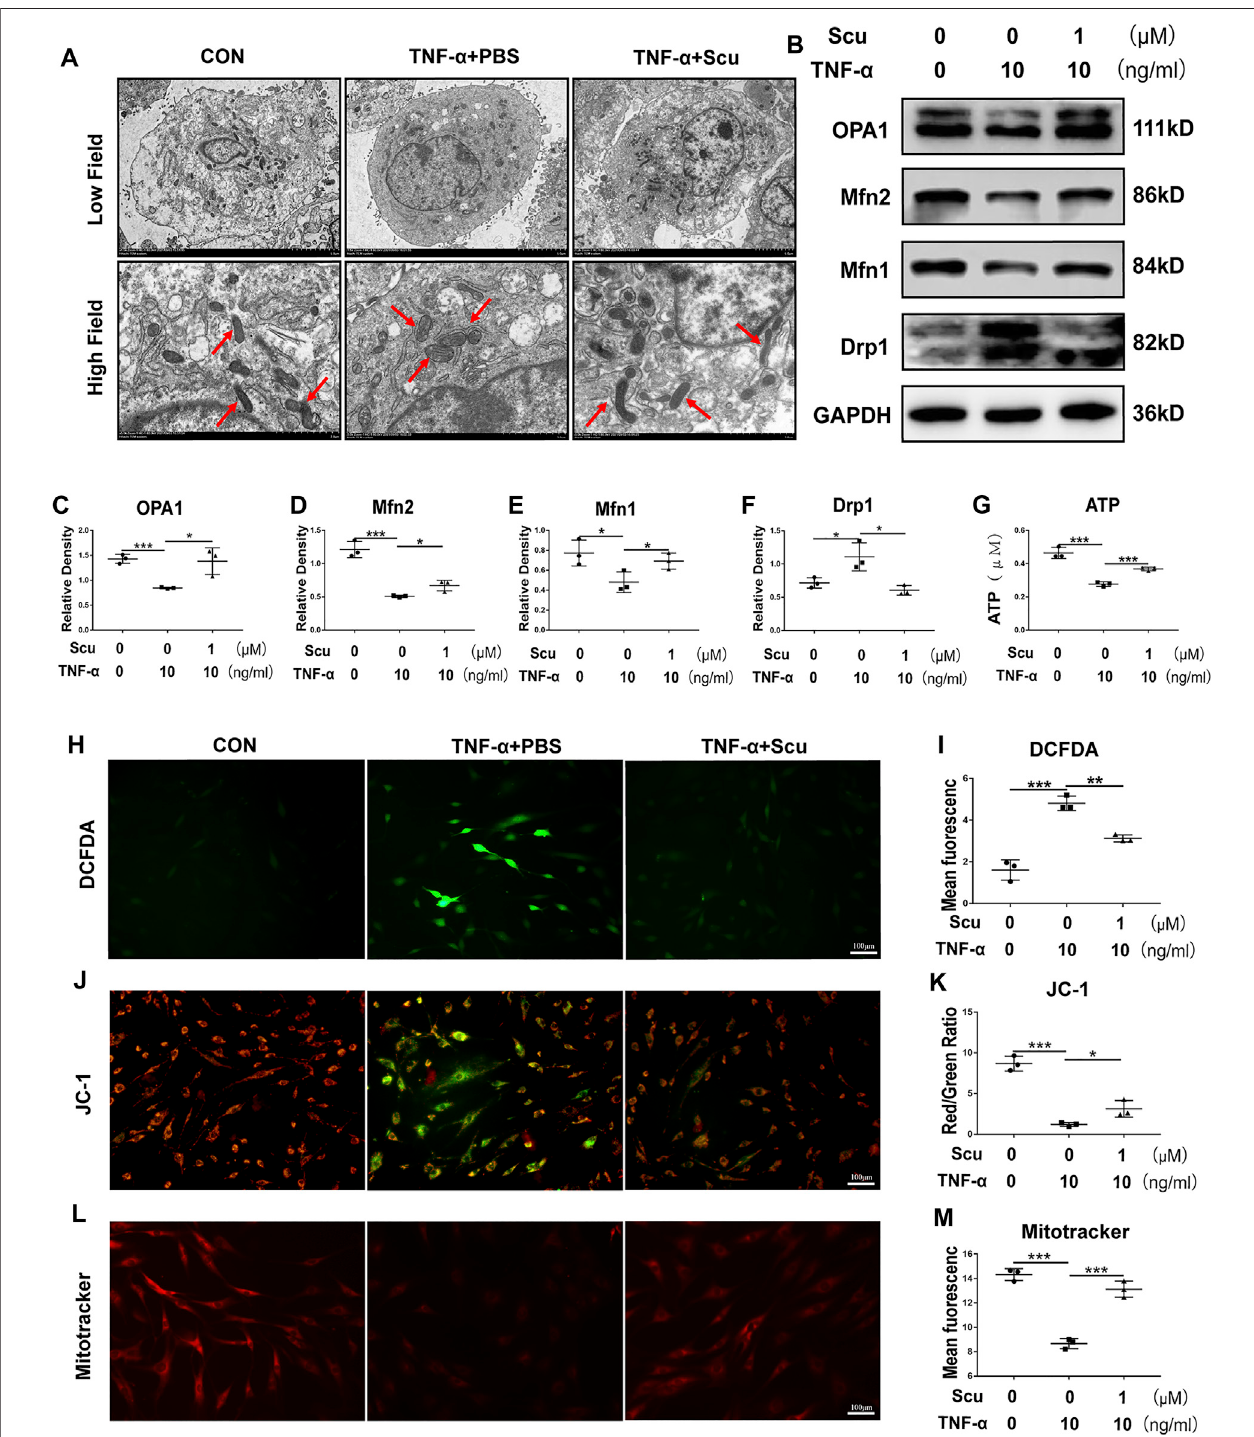
FIGURE 4 | Scutellarin reversed oxidative stress and mitochondrial dysfunction and reduced ATP production induced by TNF- α in HNPCs. (A) HNPCs were culturedwithPBS,TNF- α (10 ng/ml),TNF- α (10 ng/ml)+scutellarin(1 μ M)for24 h.ThemitochondrialmorphologyofHNPCswasobservedusingTEM(scalebar:5 μ m). (B – F) Aftertreatmentasindicatedfor48 h,total protein wasextractedfromeach group.Theprotein levels ofOPA1,Mfn1,Mfn2, andDrp1 ineach group weredetected by Western blotting. (G) ATP levels of HNPCs in each indicated group were examined. (H,I) ROS levels in HNPCs in each indicated group were detected with DCFDA (scale bar: 100 μ m). (J,K) JC-1 was used to detect the mitochondrial membrane potential of HNPCs in each indicated group (scale bar: 100 μ m). (L,M) MitoTracker was used to detect the mitochondrial membrane potential of HNPCs treated as indicated (scale bar: 100 μ m). Each experiment was performed three times independently. (* p < 0.05, ** p < 0.01, *** p < 0.001).